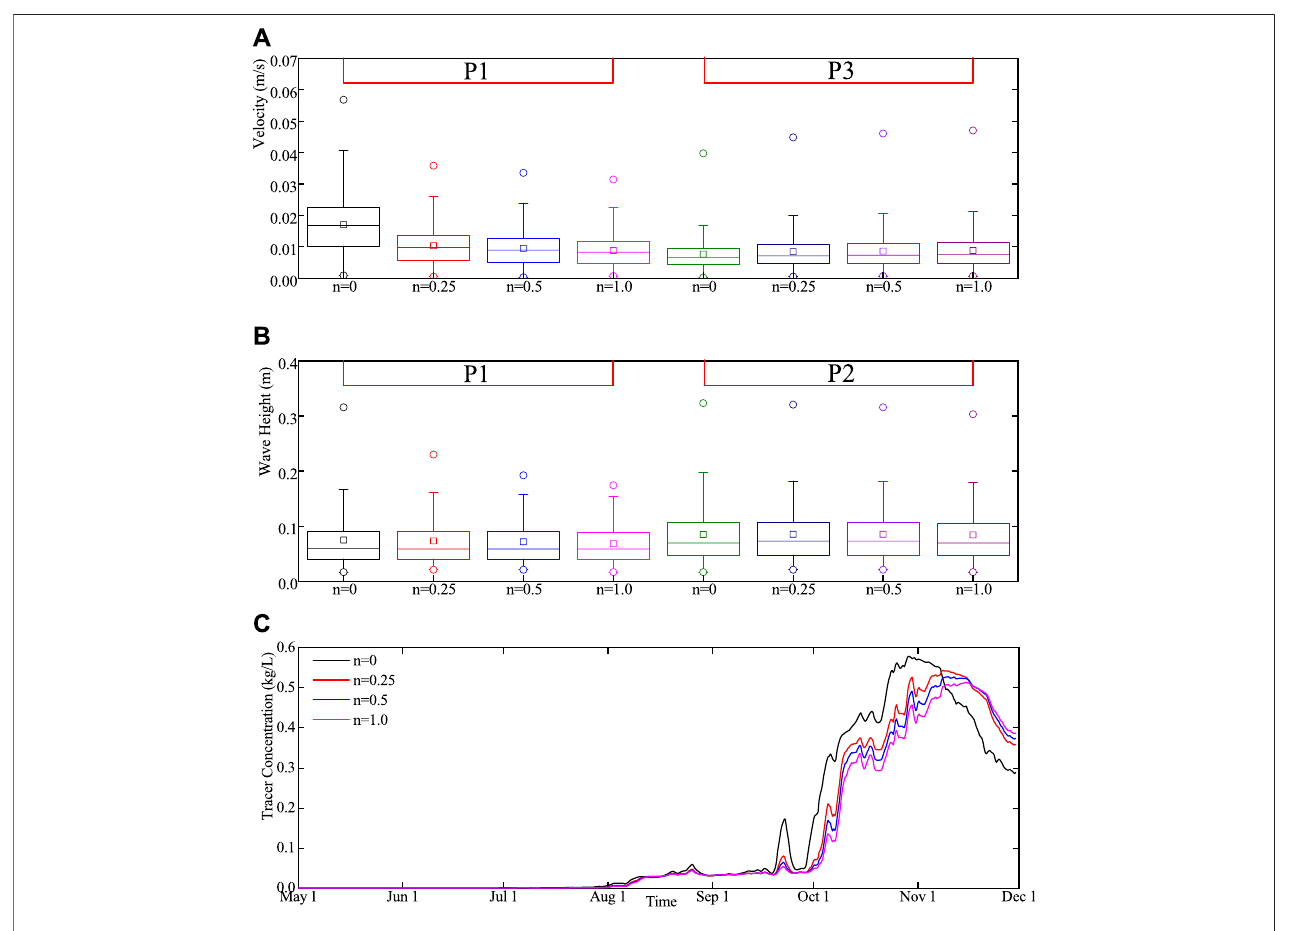
FIGURE 16 | Sensitivity analysis of the in fl uence of vegetation density on the results: (A) sensitivity analysis of velocity at P1 and P3, (B) sensitivity analysis of wave height at P1 and P2, and (C) sensitivity analysis of tracer concentration at P1.